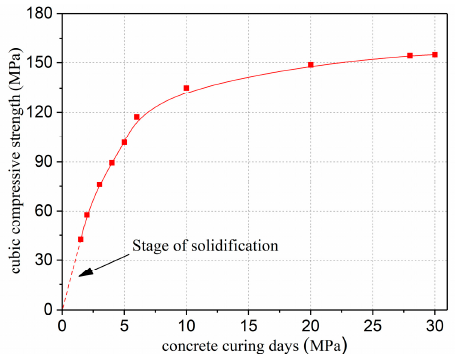
Figure 5. Figure 5. The change in cubic compressive strength of UHPC with curing days under normal